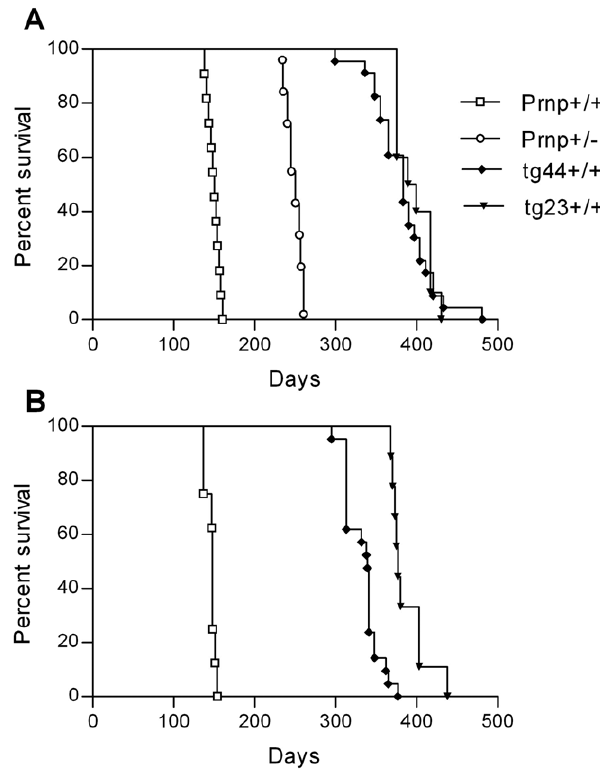
Figure 2. Survival curves for scrapie-infected mice. Transgenic mice (tg44 + / + and tg23 + / + ) expressing only anchorless PrP, C57BL/10 (Prnp + / + ) and Prnp + / 2 mice, expressing normal anchored mouse PrP were compared. Mice were inoculated intracerebrally with 22L scrapie (panel A) and RML scrapie (panel B) and observed weekly for development of disease (see Table 1). Mice were euthanized when clinical signs were severe as described in Table 1. N values for each group are as follows: Panel A (22L): Prnp + / + , 11; Prnp + / 2 , 17; tg44 + / + , 23; tg23 + / + , 10. Panel B (RML): Prnp + / + , 8; tg44 + / + , 21; tg23 + / + , 9.